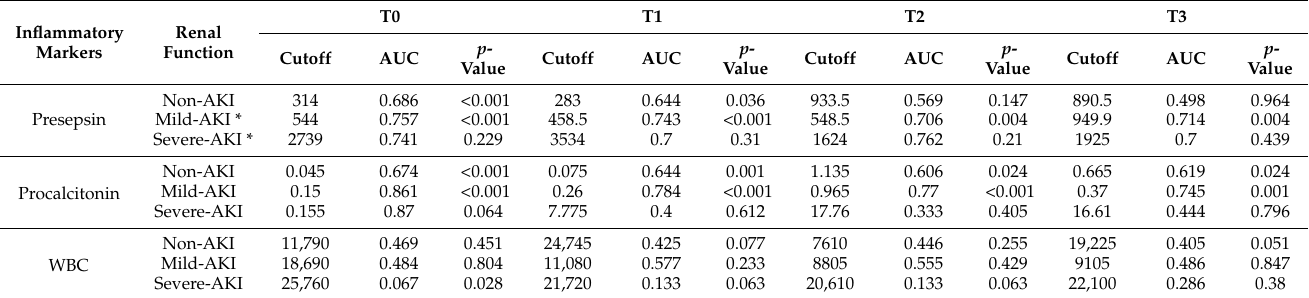
Table 7. Accuracy of inflammatory markers in predicting postoperative sepsis according to AKI severity, by period. Inflammatory